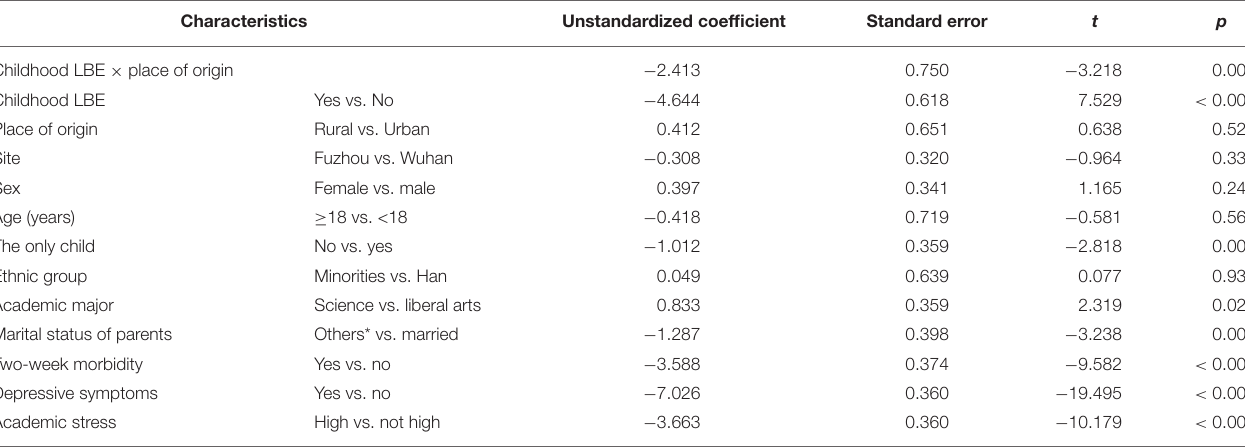
TABLE 3 | Multiple linear regression on interactive effect of childhood left-behind experience (LBE) and place of origin on quality of life (QOL) among freshmen, adjusting for the confounding effects of sociodemographic variables, physical health, depressive symptoms, and academic stress. Characteristics